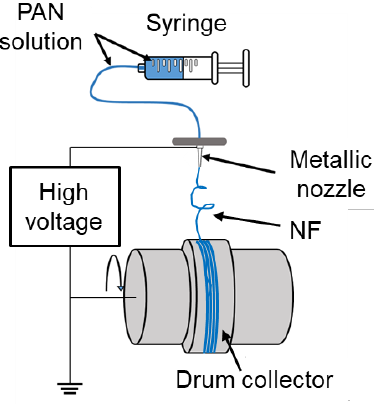
Figure 5. Basic schematic of the electrospinning system.